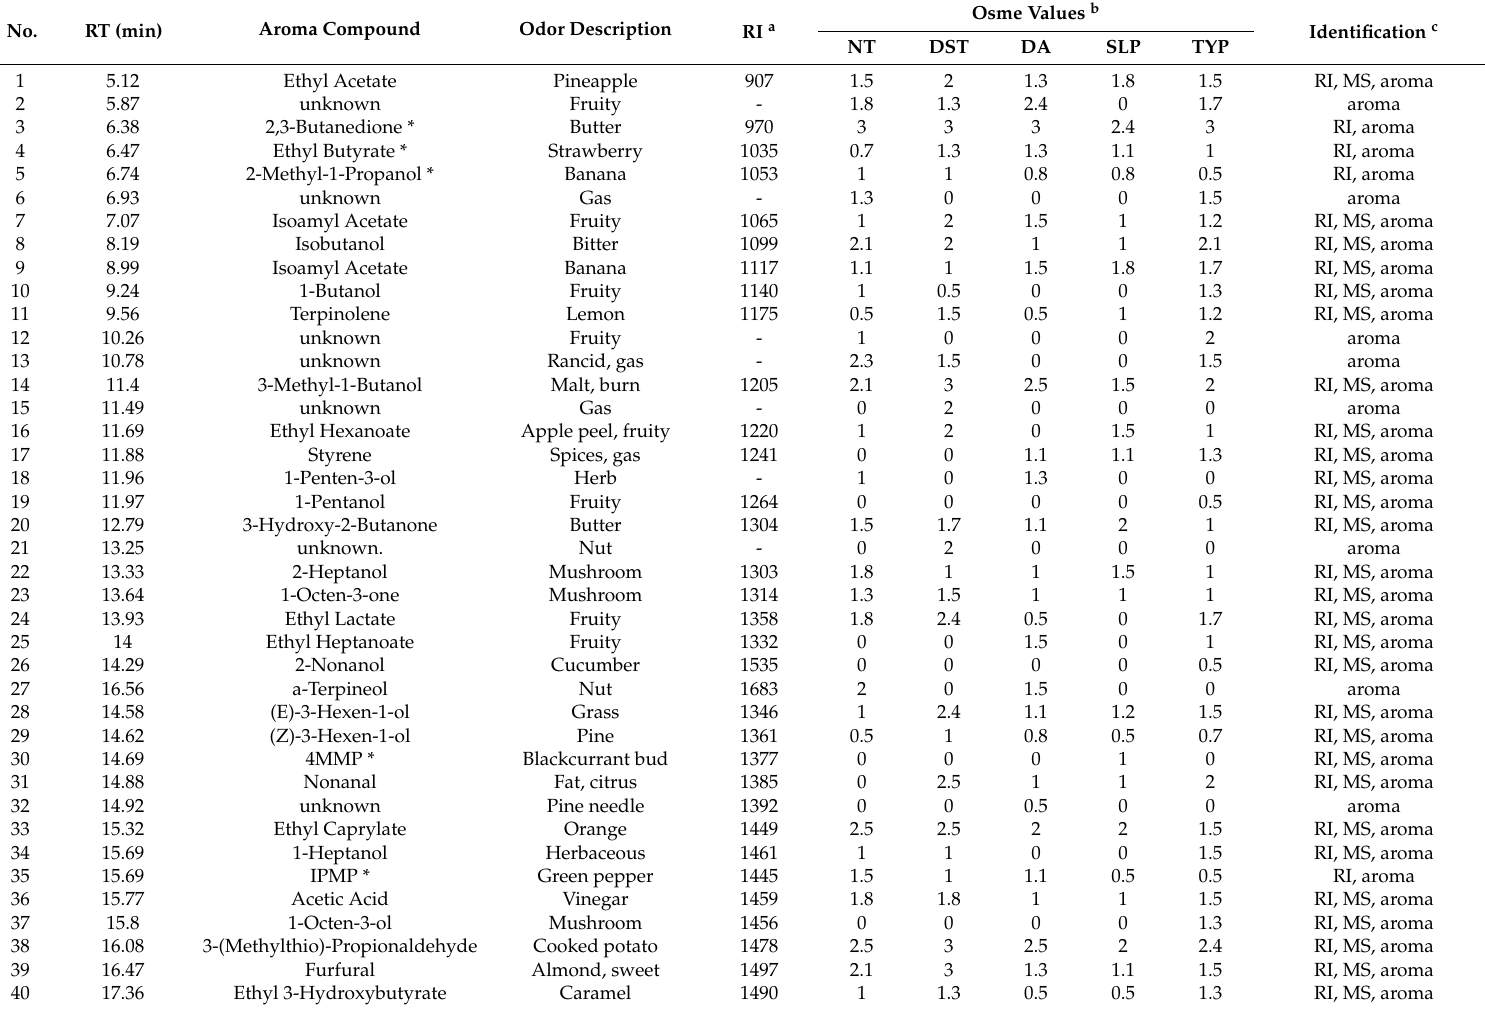
Table 1. Aroma compounds identified by gas chromatography–olfactometry (GC–O) in five Cabernet Sauvignon